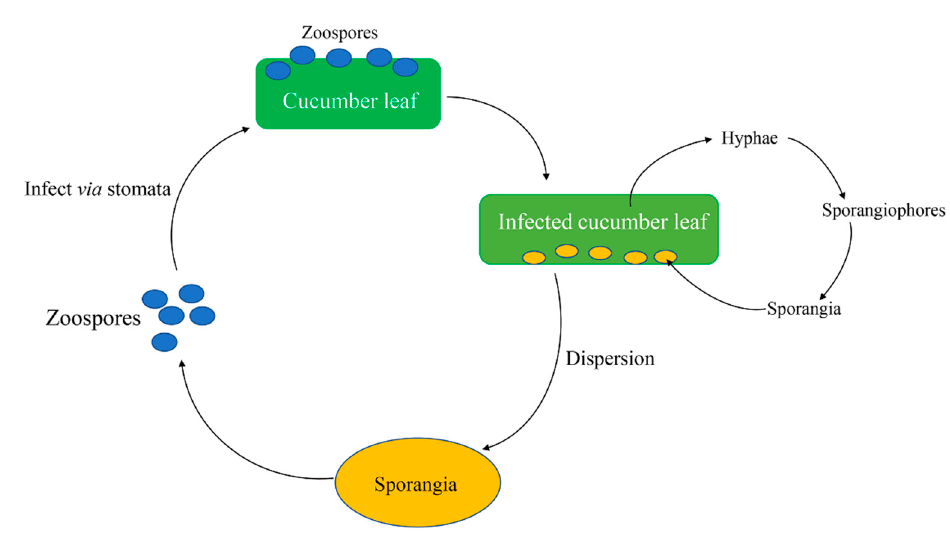
Figure 1. Infection cycle of Pseudoperonospora cubensis .